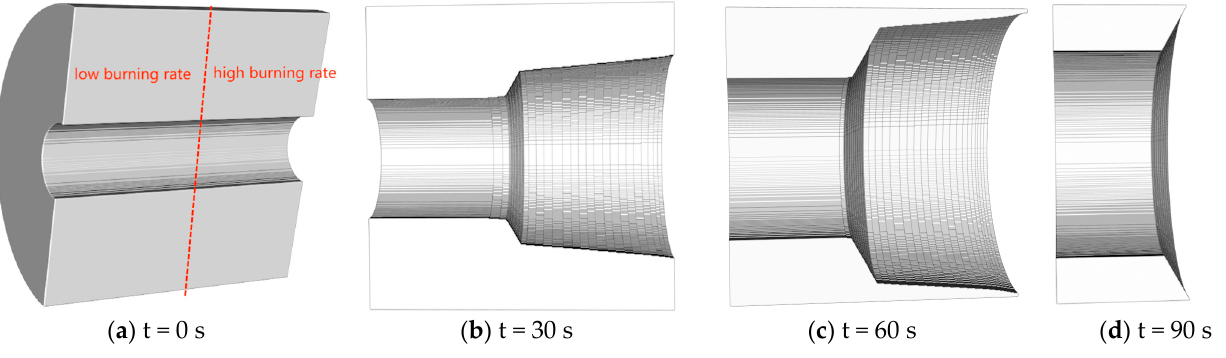
Figure 15. Comparison of the burning surface area of geometric theoretical value with synthesis algorithm under erosive burning and under geometrical law of burning.